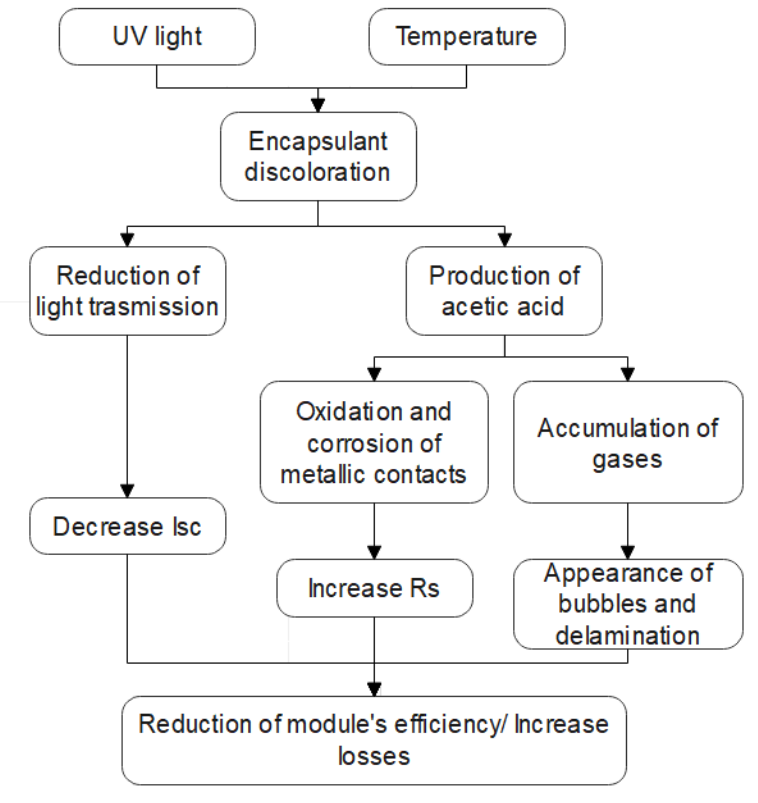
Figure 8. Encapsulant discoloration causes and effects [57]. One of the initial effects is the reduction of the transmissivity of the encapsulant caused by the change of the encapsulant color as represented in Figure 9b. This effect occurs when the module is exposed to UV radiation and temperatures above 50 ◦ C [58]. The intensity of the discoloring varies from yellow shade, brown, and dark brown. This discoloration impacts the amount of solar irradiance that reaches the surface of the solar cell. As a consequence of the lower irradiance levels, the short-circuit current I sc of the cell/module reduces, as seen in the I-V curve in Figure 10. impacting directly on the module’s efficiency [56,57].